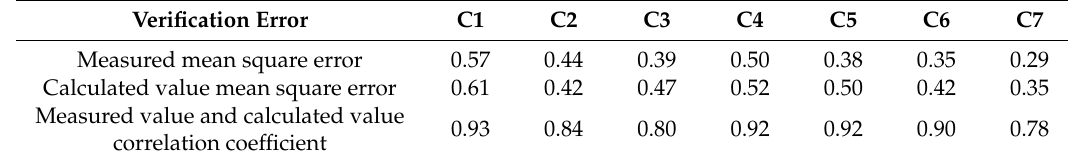
Table 3. Tidal current velocity verification error.